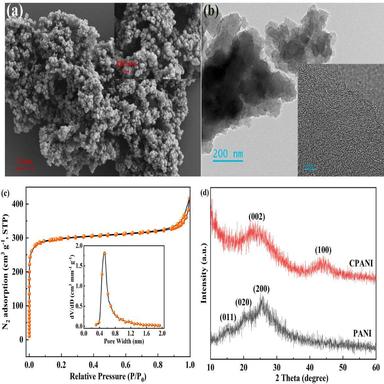
(a) SEM images and (b) TEM images of CPANI. (c) Nitrogen adsorption-desorption isotherm of CPANI. (d) XRD patterns of PANI and CPANI samples.